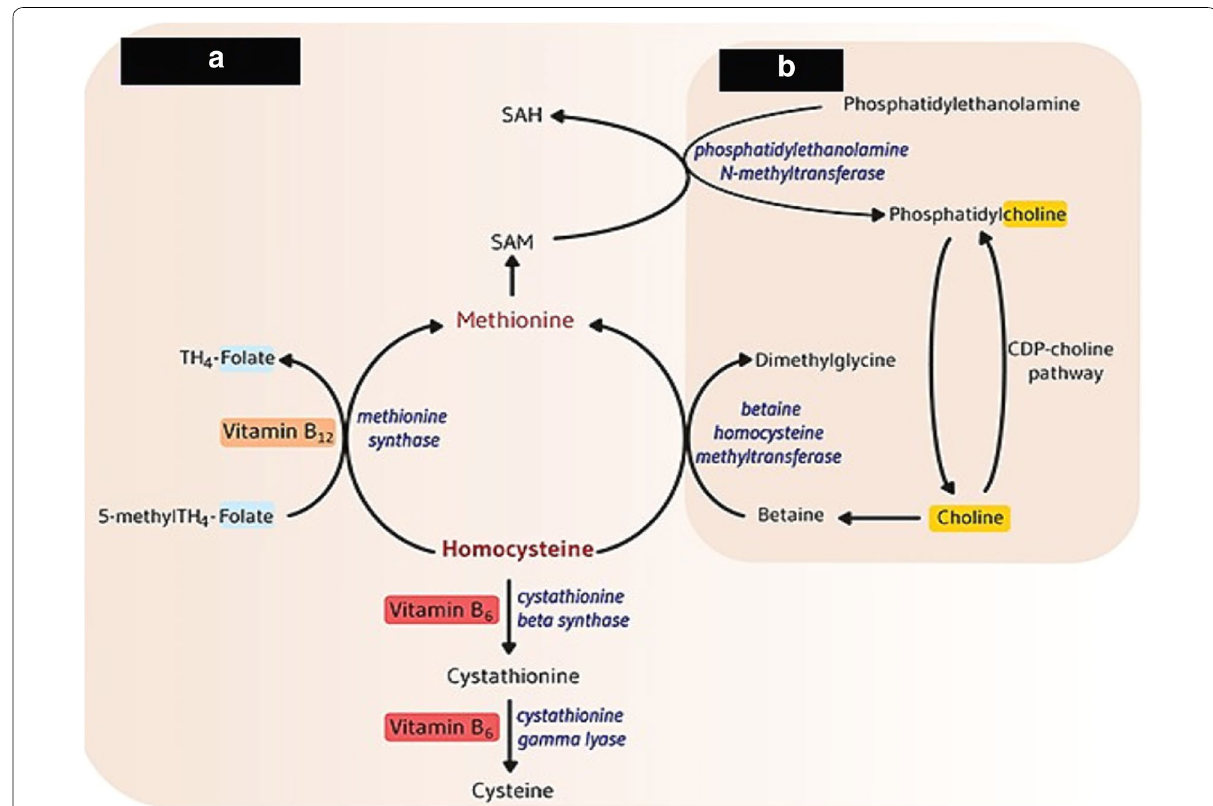
Fig. 1 a Methylation reaction pathway of homocysteine, to form essential amino acid methionine and another choline metabolite betaine, dependent pathway as methyl donor for methylation of homocysteine for methionine formation and b demonstrated that methionine as a univer‑ sal donor of S ‑adenosyl methionine (SAM) which contribute to convert phosphatidylethanolamine into phosphatidylcholine to generates